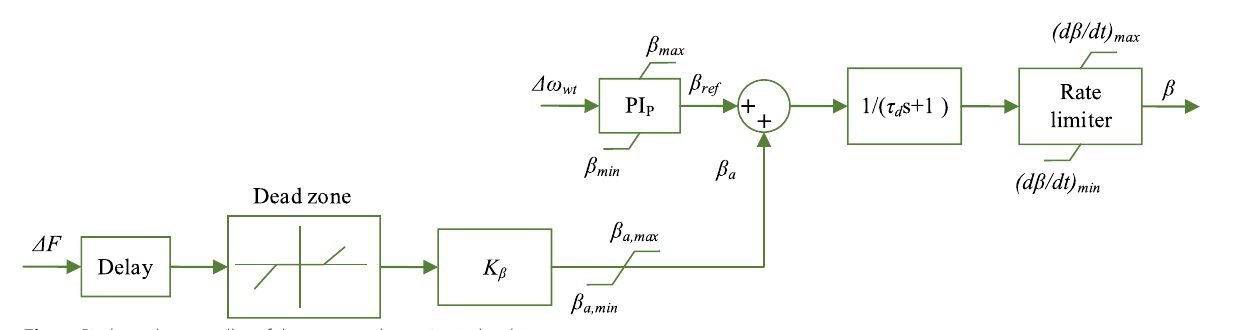
Fig. 5 Pitch angle controller of the proposed type 3 wind